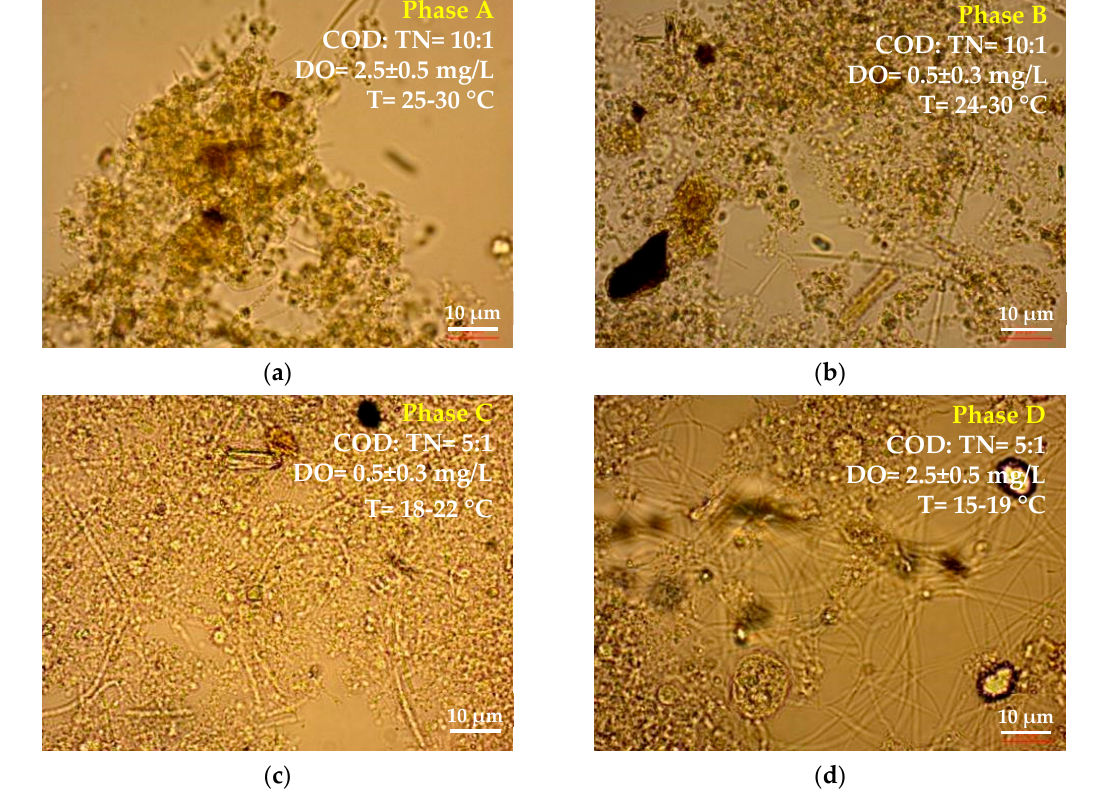
Figure 3. Typical optical microscopy images from: ( a ) Phase A (FI = 0–1, T = 25–30 °C); ( b ) Phase B (FI = 1–2, T= 24–30 °C); ( c ) Phase C (FI = 2–3, T = 18–22 °C); ( d ) Phase D (FI = 3–4, T = 15–19 °C).